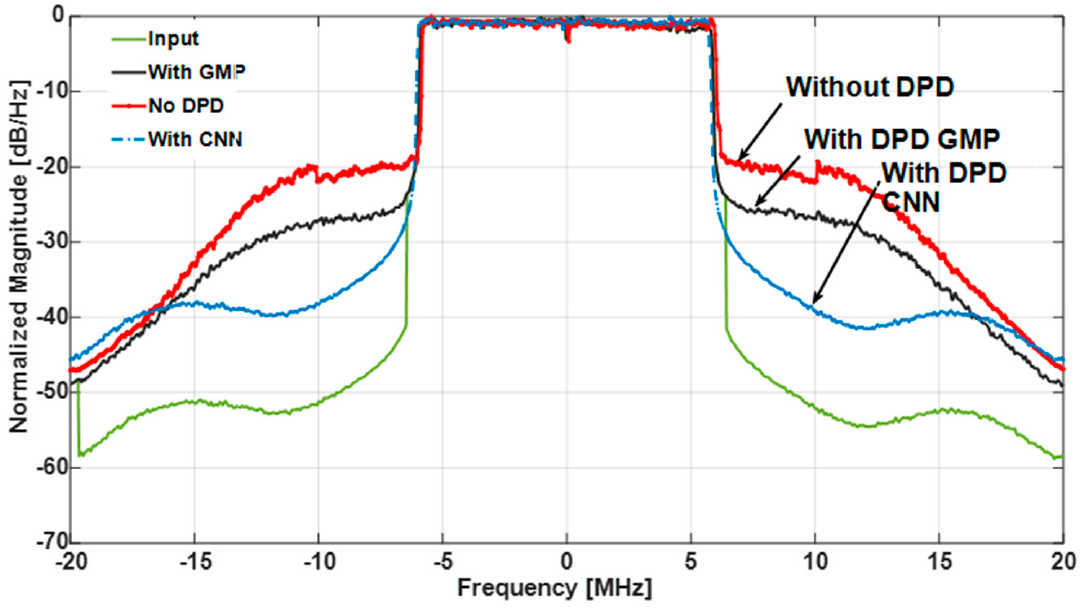
Figure 6. PSD performance comparison with and without DPD.